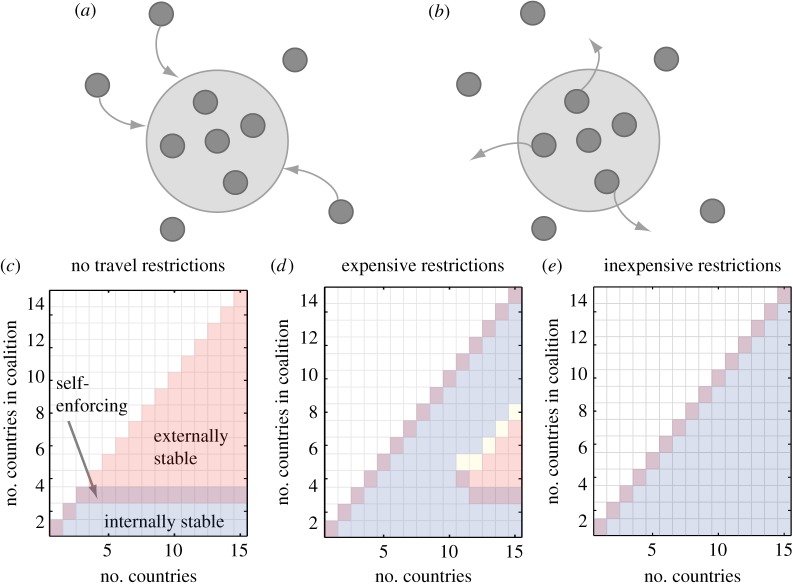
Coalition stability. (a) Externally unstable coalition—benefits of the coalition are greater than the free-riding pay-off, giving non-signatories the incentive to join. (b) Internally unstable coalition—benefits of free-riding are greater than benefits from coalition giving signatories an incentive to defect. (c–e) Effects of travel restrictions on coalition stability for different numbers of interconnected countries n (x-axis) and for increasing numbers of signatories k (y-axis). Blue shading shows internally stable coalitions, externally stable coalitions are shaded orange, and their overlap shows self-enforcing coalitions. Coalitions in yellow are neither externally nor internally stable, and area in white shows unfeasible coalitions. R0 = 5, coupling strength = 20μ/(n − 1), ai = 0.1, cIi = 5. (c) No travel restrictions, (d) expensive travel restrictions, q = 1000, (e) inexpensive travel restrictions, q = 5000.